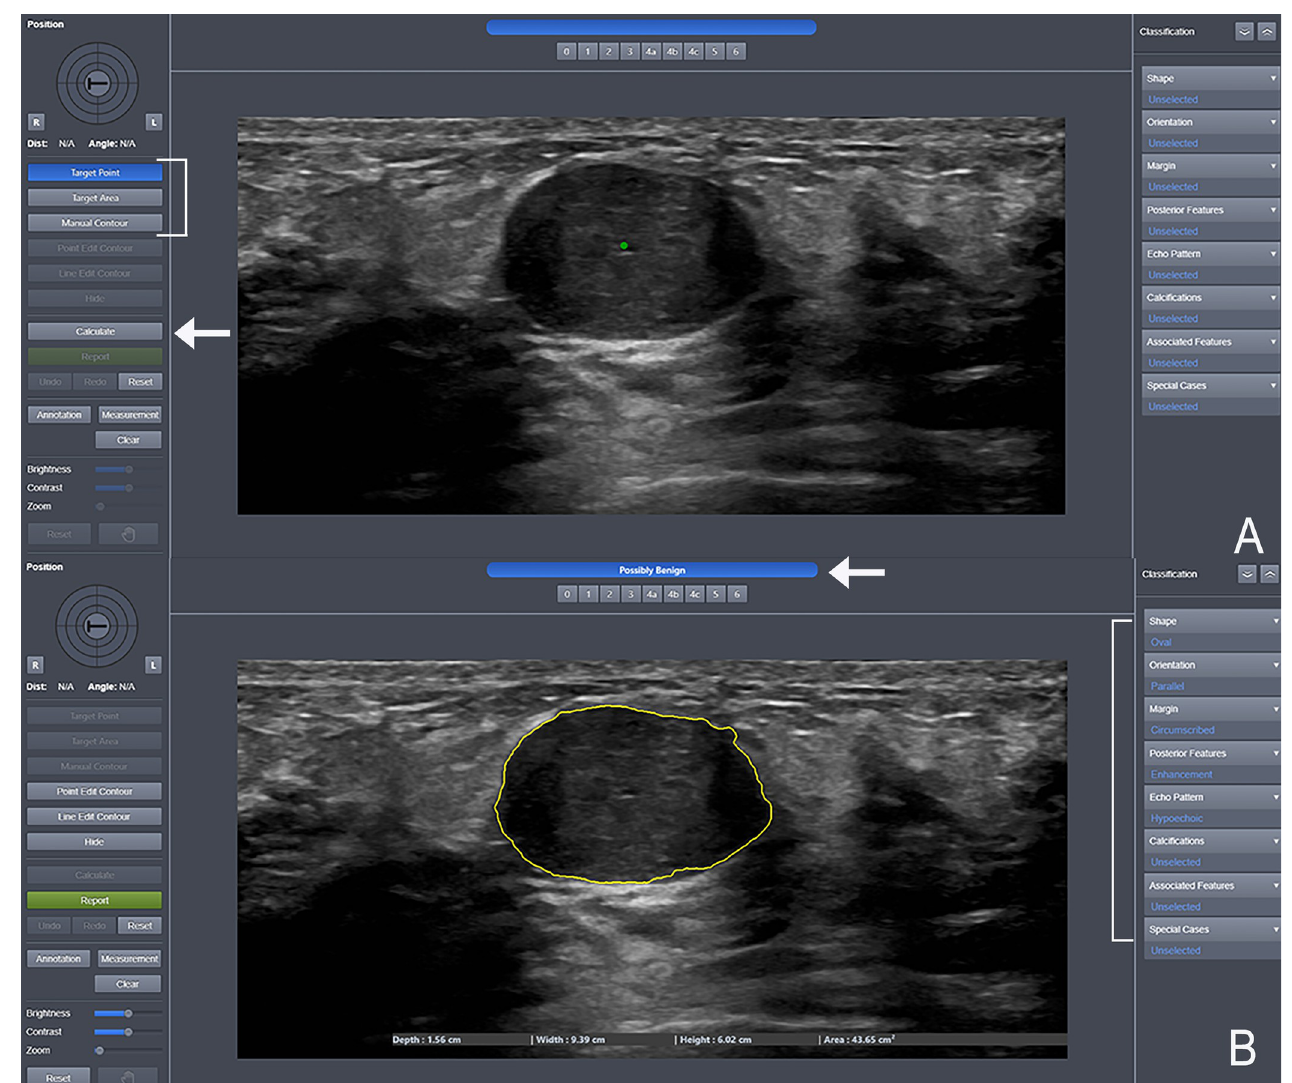
Fig 6. Screenshots of S-Detect User Interface. (A) Screenshot showing the S-Detect user interface. There are three possible methods to target the mass in S-Detect (bracket). In this screenshot, the “Target Point” method has been used. This method involves placing a single point within the target mass (green dot). This could also be accomplished using a “Target Area” or manually outlining the mass boundaries using the “Manual Contour” option. Once the mass has been targeted, S-Detect will produce an interpretation after pressing the “Calculate” button (arrow). (B) Screenshot showing the results after a mass has been targeted. S-Detect outputs a result of “possibly benign” or “possibly malignant” (arrow) as well as a list of mass characteristics (bracket). The mass segmentation is outlined in yellow and this can be adjusted or redone if